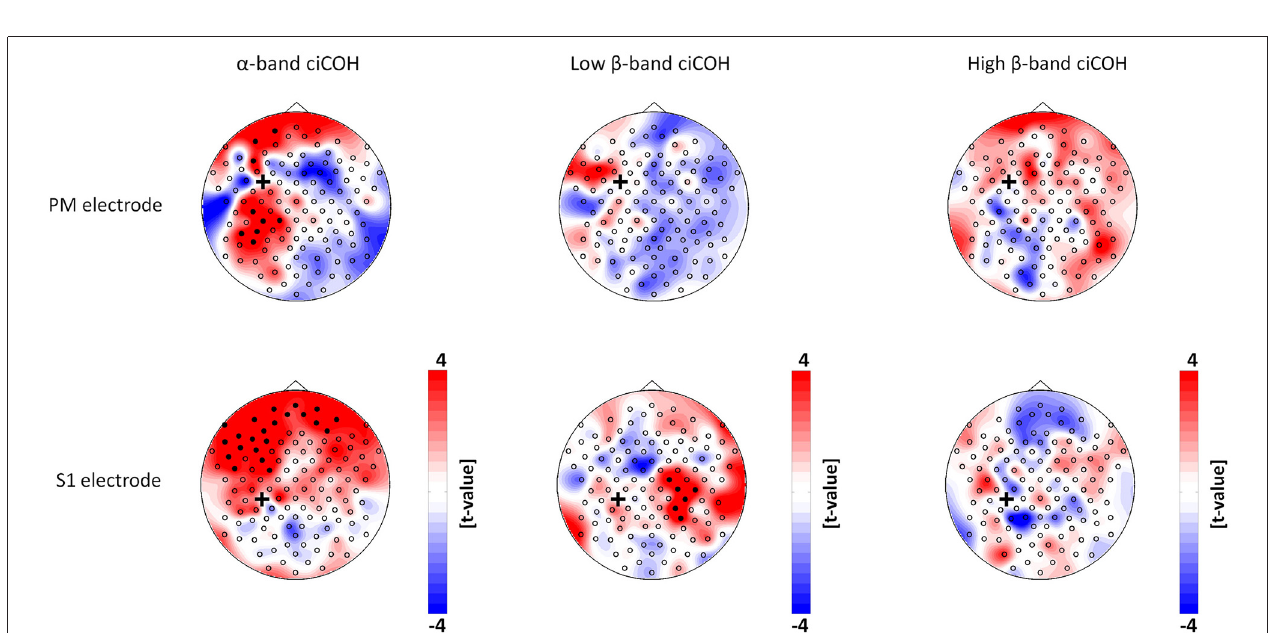
FIGURE 2 | Connectivity changes of the primary motor cortex. The plots show t -value topographies of ciCOH for POST vs. PRE differences of intrinsic oscillatory activity in the α -band, low β -band, and high β -band. Electrode clusters, displaying significant differences in the non-parametric statistical